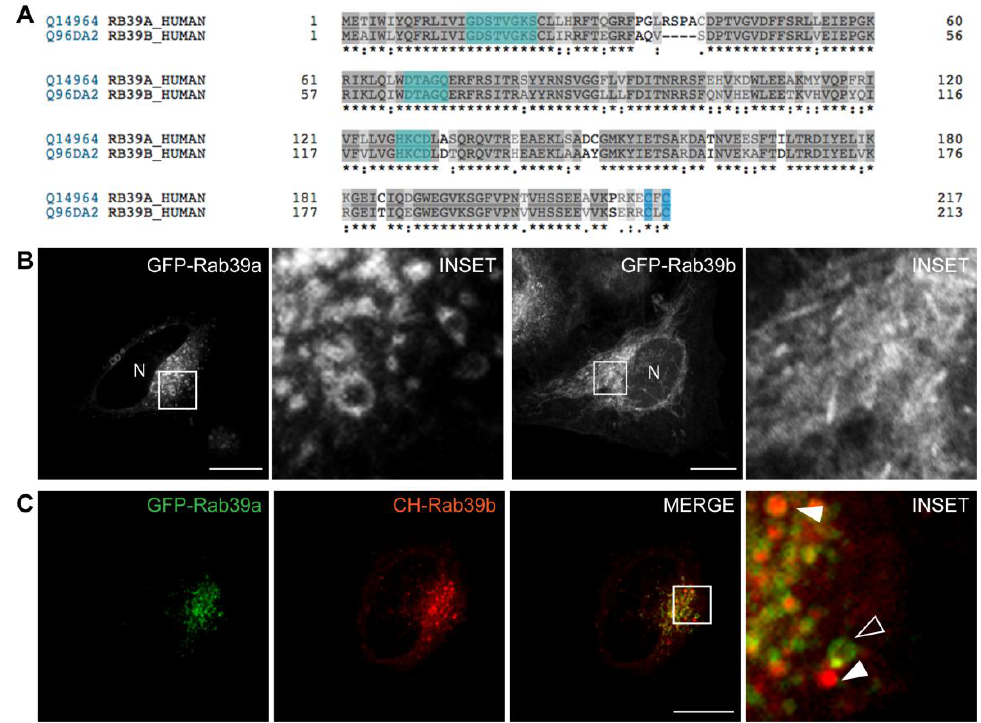
Figure 1. Rab39a and Rab39b isoforms. ( A ) In silico alignment with Uniprot of Rab39a and Rab39b proteins. Amino acid identity of both isoforms is 76.9% (grey) with identical nucleotide binding sites (cyan) and C-terminal prenylation signals (light blue). ( B ) HeLa cells overexpressing GFP-Rab39a ( left ) or GFP-Rab39b ( right ). N indicates nuclei. ( C ) GFP-Rab39a (green) and CH-Rab39b (red) were co-expressed in HeLa cells. Pearson coefficient (r) was calculated with the analysis of 30 cells with ImageJ. The open arrowhead indicates a vesicle decorated with GFP-Rab39a, whereas filled arrowheads point out CH-Rab39b-labeled vesicles. ( B , C ) Images were taken by live cell spinning disk microscopy. Images are representative of three independent experiments. Scale bars represent 10 µm.